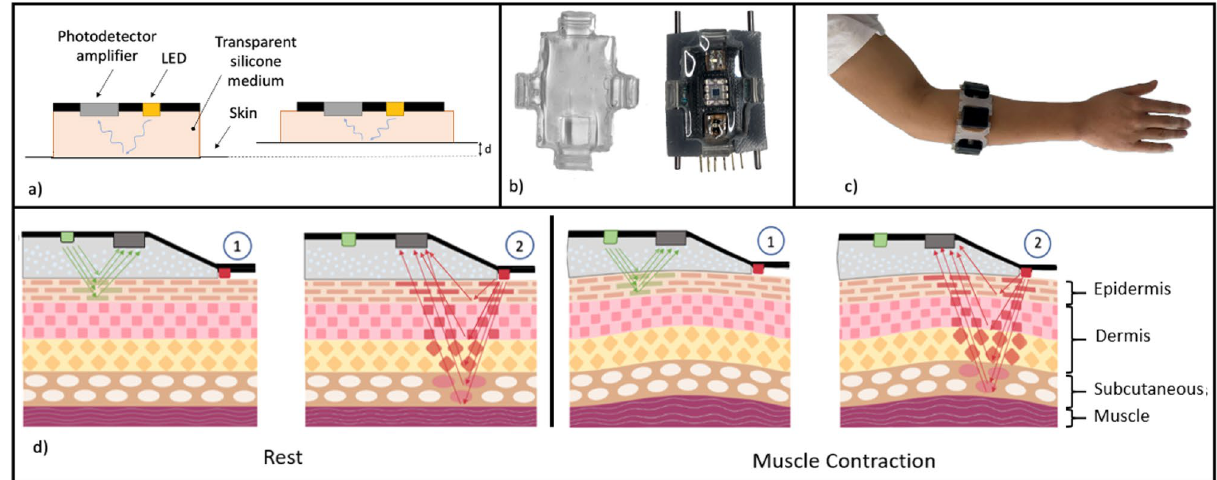
Figure 1. Working principle of the Lightmyography. ( a ) shows a simple module with one LED and one photodiode. ( b ) shows the developed modules of the proposed armband that are equipped with two photodiodes and a single photodetector. ( c ) shows the proposed armband worn on the upper half of a human forearm. Finally, ( d ) shows the working principle of the Lightmyography method, where different lights of different wavelengths penetrate the skin in different depths and get reflected on the tissue before they travel back to the skin surface to be captured by the photodetector. Muscle contractions become tissue deformations that affect the light luminosity that gets captured by the photodetector, and thus can be easily detected.